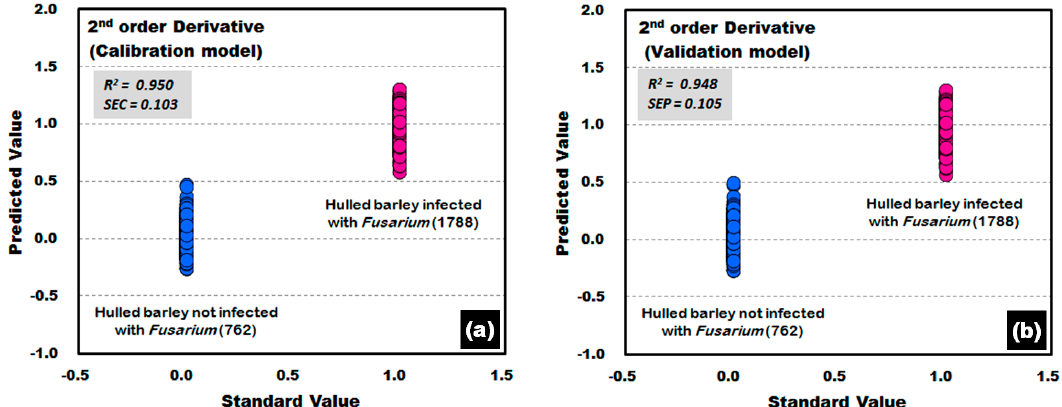
Figure 12. Fusarium discrimination calibration ( a ) and validation ( b ) results of PLS-DA model developed by applying the second-order derivative pretreatment to the reflectance spectra obtained from the front side and back side of hulled barley.